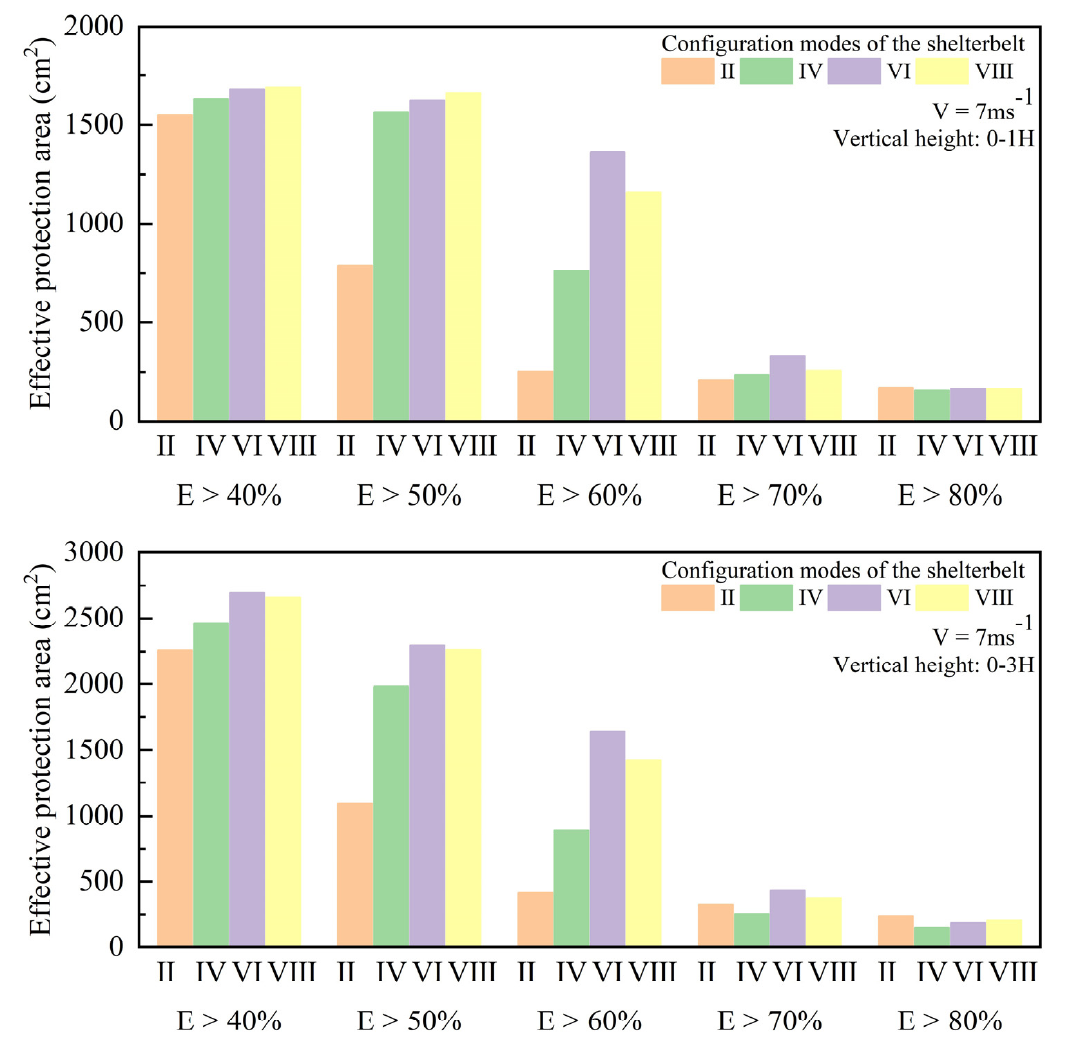
Figure 7. Effective protection area in the range of 0–10H behind the single shelterbelt. The abscissa represents the shelterbelt configuration under the specific shelter efficiency and the ordinate represents the effective protection area (cm 2 ). (V) 7 m·s − 1 .